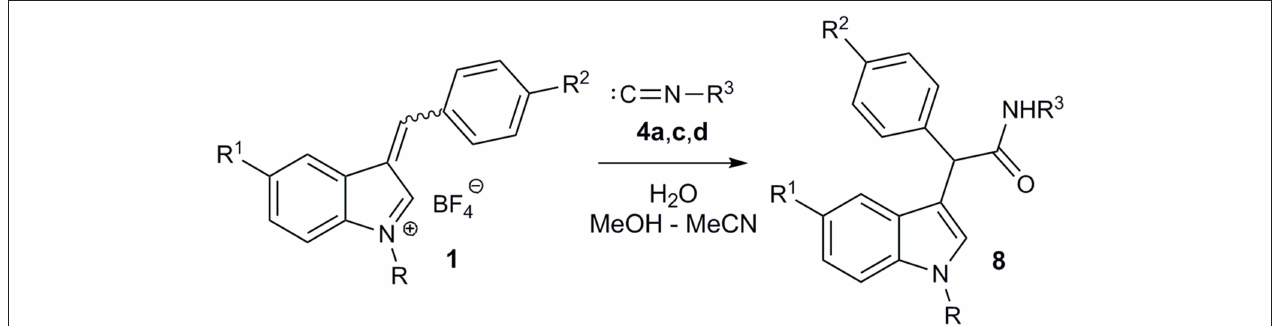
FIGURE 6 | Synthesis of amides 8